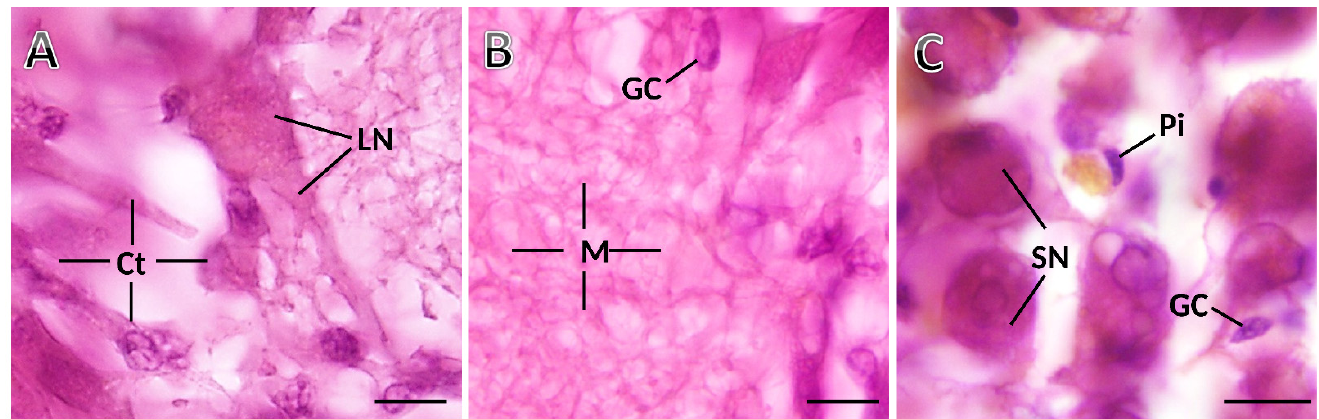
Figure 3. Photomicrographs taken from thick histological sections of a ganglion of S. plana . ( A ) Cortex (Ct), with a standing-out large neuron (LN). ( B ) Medulla (M), with neuronal and glial eosinophilic projections, and somata of glial cells (GC). ( C ) Detail of cortex, where smaller neurons (SN), one elongated glial cell (GC) and one pigment cell (Pi) are seen. Six animals per sex condition were used. H&E Staining. Scale bar: 10 µm.